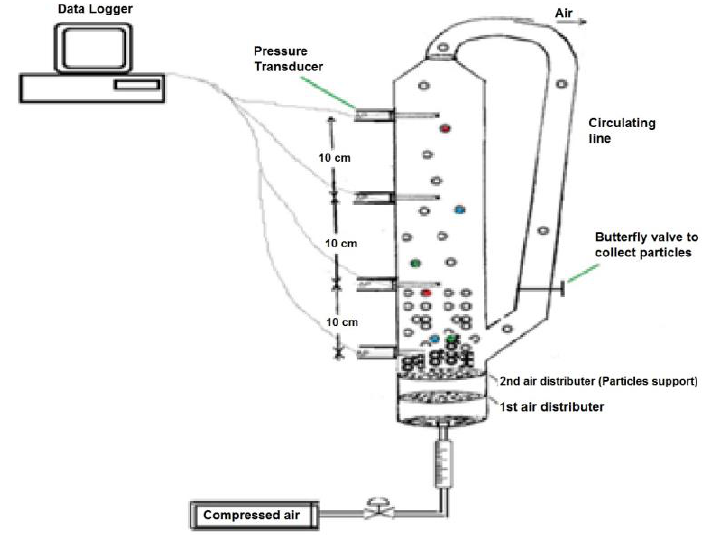
Figure 2. Small column set-up for measurement of pressure drop.